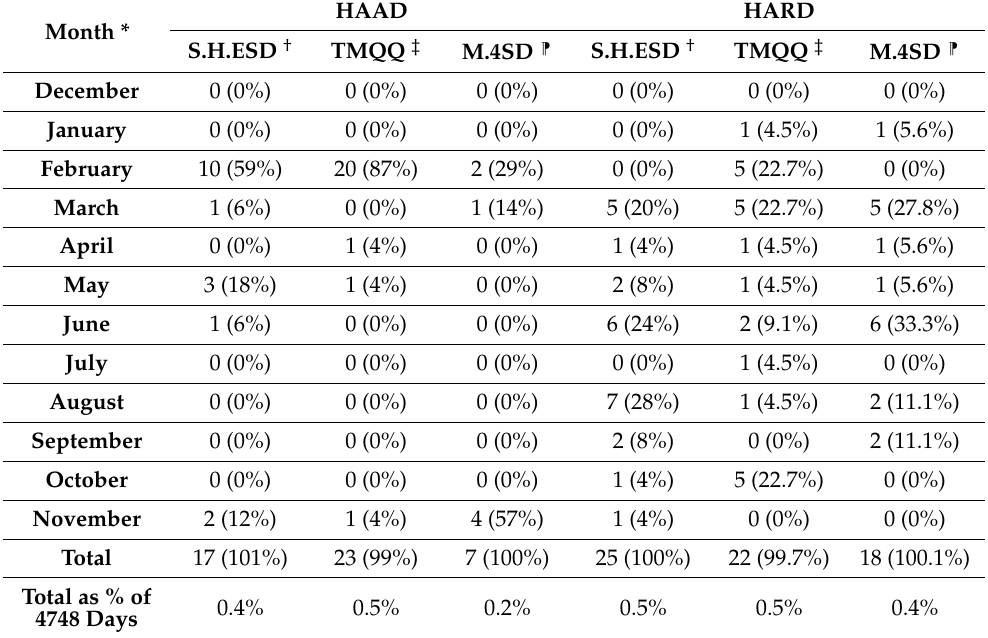
Table 1. Number of days classified as high asthma admission (HAADs) and high asthma readmission (HARDs) daily counts with the three reviewed methods by month of occurrence over the 13 years of the study period.